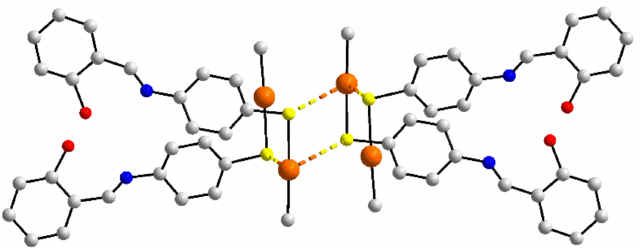
Figure 9. Supramolecular association in a zero-dimensional aggregate featuring four Hg ··· S inter- actions: 35 . The hydroxyl-H atoms were not located in the original analysis and hence, are not